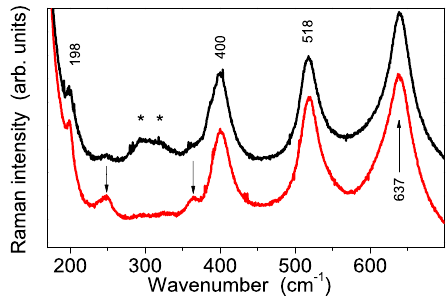
Figure 9. Experimental Raman spectra carried out in the low wavenumber region on S-TiO 2 nanopowder sample (red trace) and on nanocomposite membrane loaded by 7% w / w of S-TiO 2 (black trace). The two arrows indicate the TiO 2 -B phase modes at about 250 and 310 cm − 1 , respectively, while the pair of stars ( * ) labels the Nafion peaks at about 292 cm − 1 (t(CF 2 )) and 310 cm − 1 , assigned to the t(CF 2 ) mode [25].